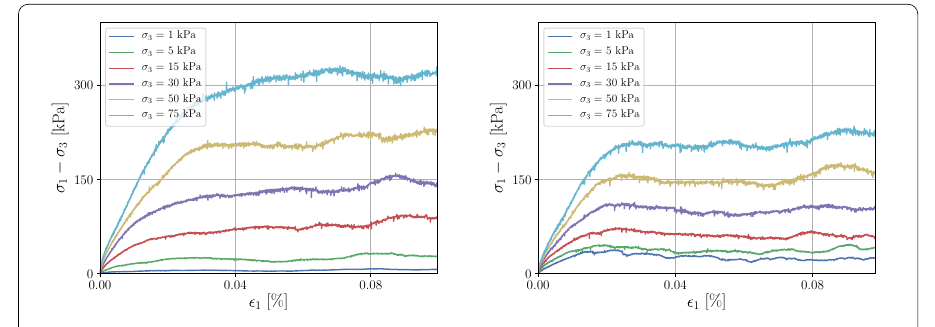
Fig. 5 The principal stress as function of the vertical strain from triaxial test on gravel-1 (left) and wet-sand-1 (right). Initially the principal stress grows nearly linearly, from which the secant modulus is determined, until shear failure occurs and the principal stress saturate